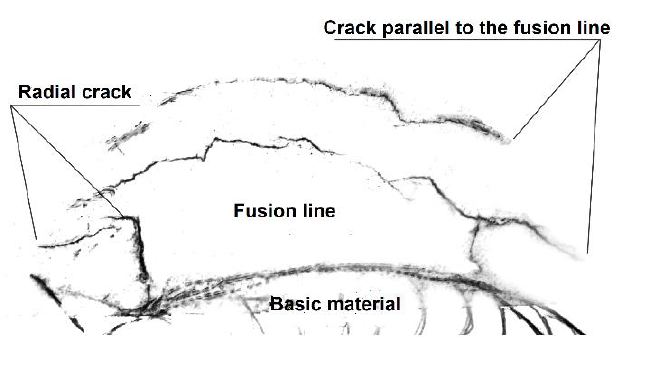
Figure 1 – X-ray of the cracked joint Рис. 1 – Рентгеновский снимок треснувшего соединения Слика 1 – Рендгенски снимак споја са прслинама